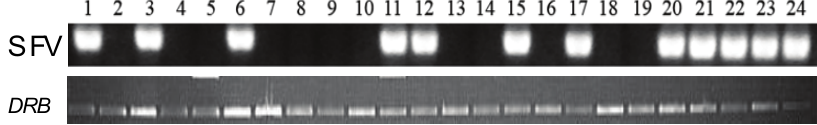
Figure 1. SFV status in monkeys by PCR analysis. Peripheral blood mononuclear cell (PBMC) DNA was isolated from 24 monkeys at 5 months prior to initiation of the study and analyzed by a nested PCR assay using SFV set B primers resulting in a 390 bp fragment. PCR amplification of a ~300 bp Mamu - DRB gene fragment was used as a control to determine the presence of intact DNA in the test